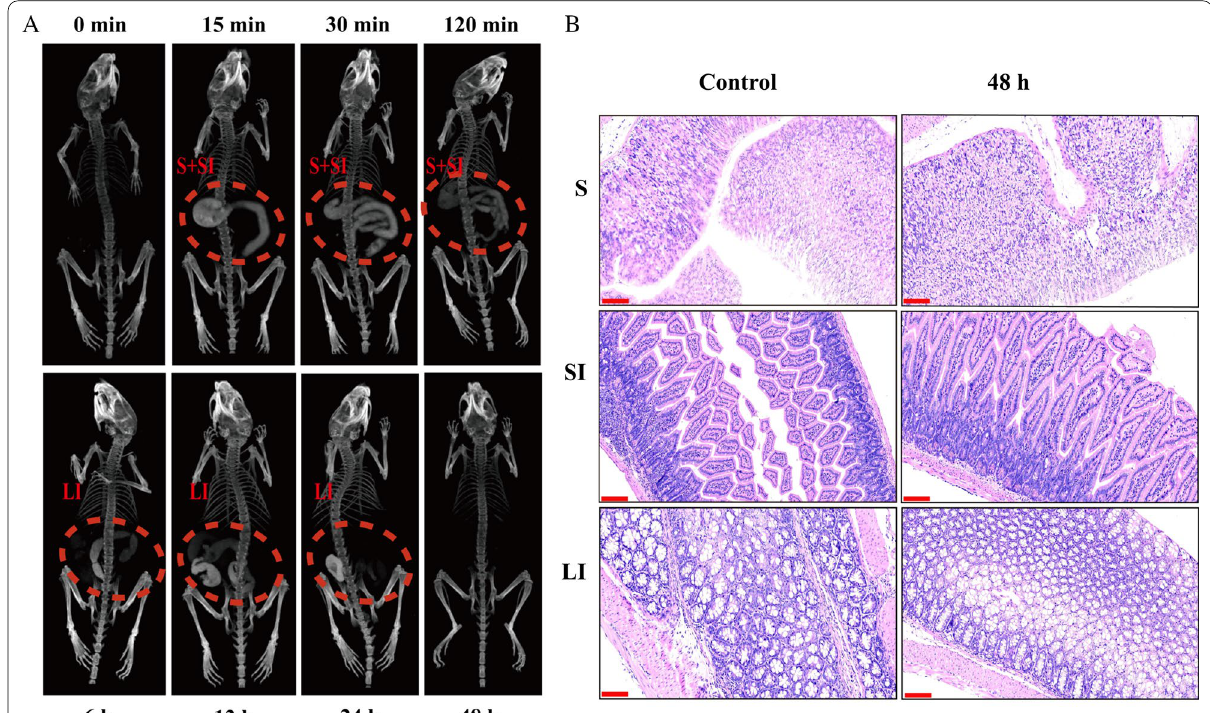
Fig. 8 A CT images of the GI tract after oral administration of BiF 3: Ln@PVP NPs at different intervals (0, 15 min, 30 min, 120 min, 6 h, 12 h, 24 h, and 48 h). B H&E staining images of stomach, small intestine, and large intestine before and after oral administration of BiF3: Ln@PVP NPs (scale bar, 200 µm). “S,” “SI,” and “LI” represent stomach, small intestine, and large intestine,